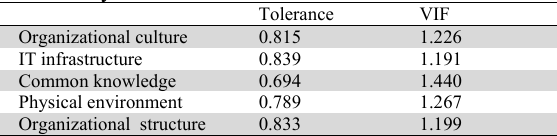
Normal Distribution Test One-Sample Kolmogorov-Smirnov Test